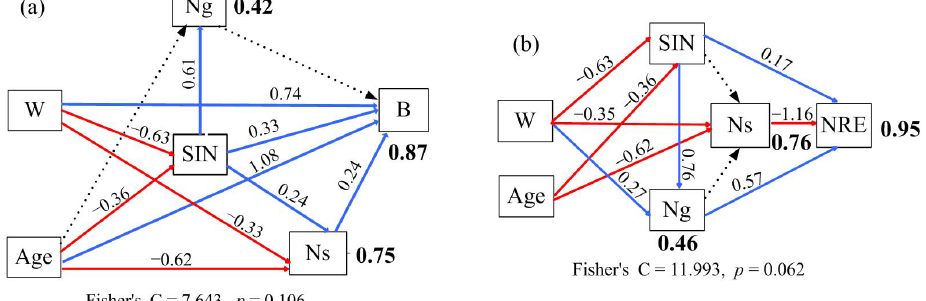
Figure 7. Controlling factor analysis of N resorption efficiency and individual plant biomass using the structural equation model. Solid and dashed lines indicate significant ( p < 0.05) and non-significant ( p > 0.05) regressions. Blue and red arrows represent positive and negative relationships, respectively. W, water; B, individual plant biomass; SIN, soil inorganic N concentration; Ng, N concentrations in green branches; Ns, N concentrations in senesced branches; NRE, N resorption efficiency. ( a ) controlling factor analysis of individual plant biomass; ( b ) controlling factor analysis of N resorption efficiency.